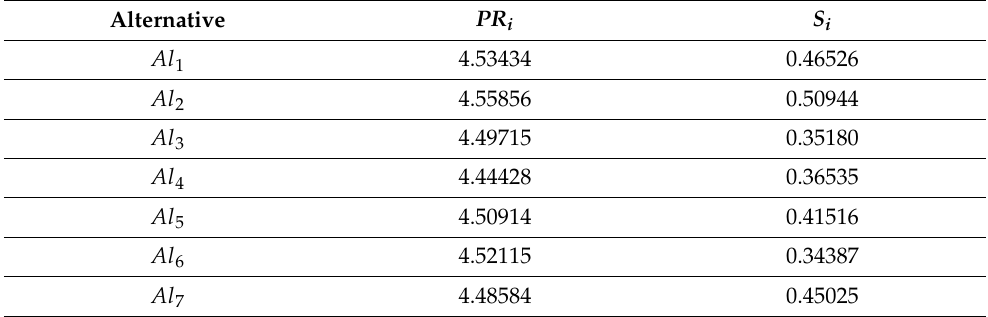
Table 13. PR i and S i values.